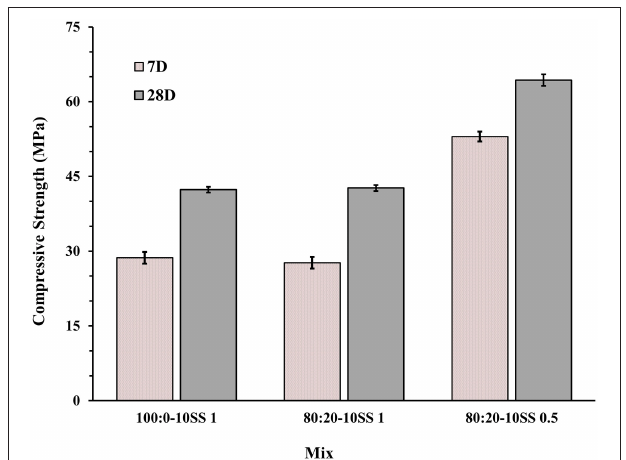
FIGURE 6 | Seven and twenty-eight days compressive strength results for concrete cubes of main